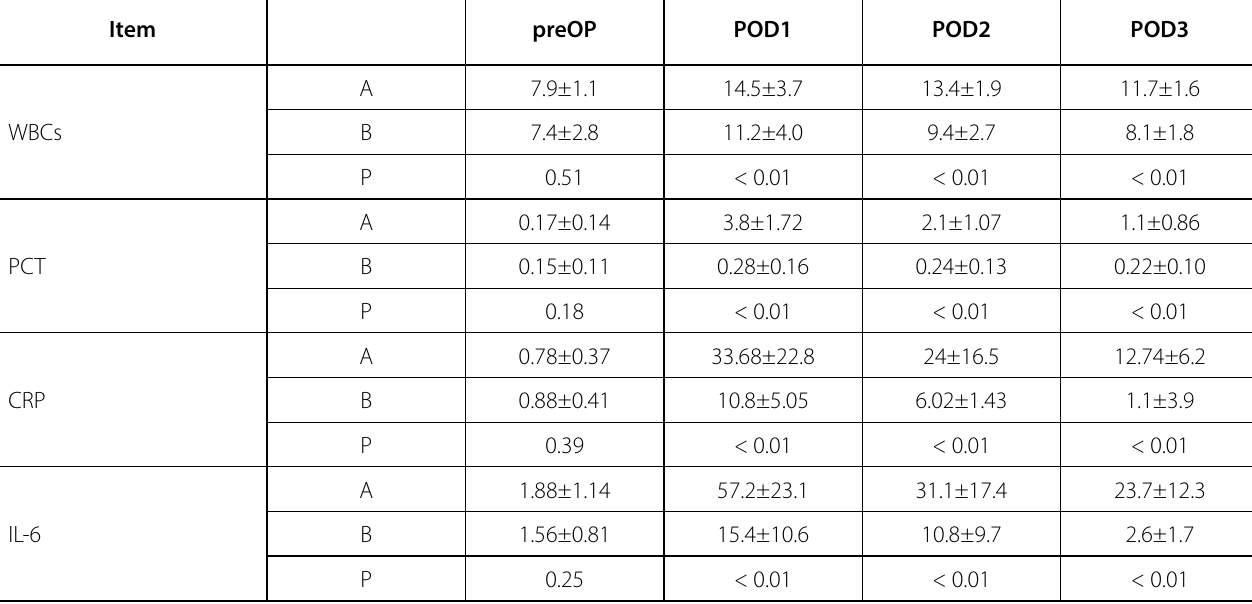
Table 3 . Changes in the levels of inflammatory markers of patients in groups A and